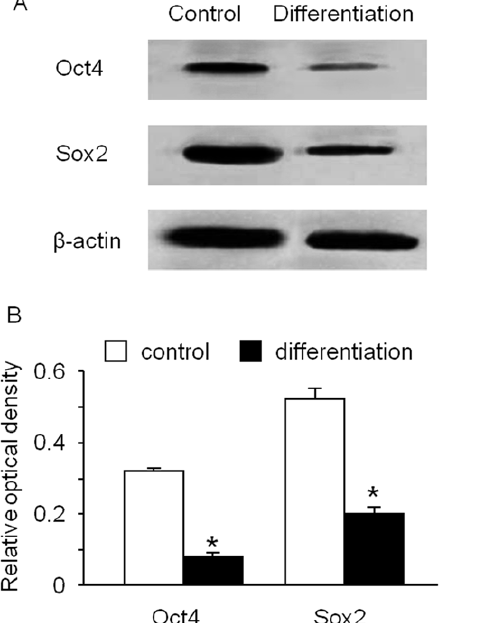
Figure 4. Cellular Oct4 and Sox2 expression after MK differentiation from hESSCs. The expression levels of Oct4 and Sox2 in cells were decreased after induction of MK differentiation (A: representative western blot bands; B: summarized data). Data are expressed as mean 6 SEM, *p , 0.01, control versus differentiation,